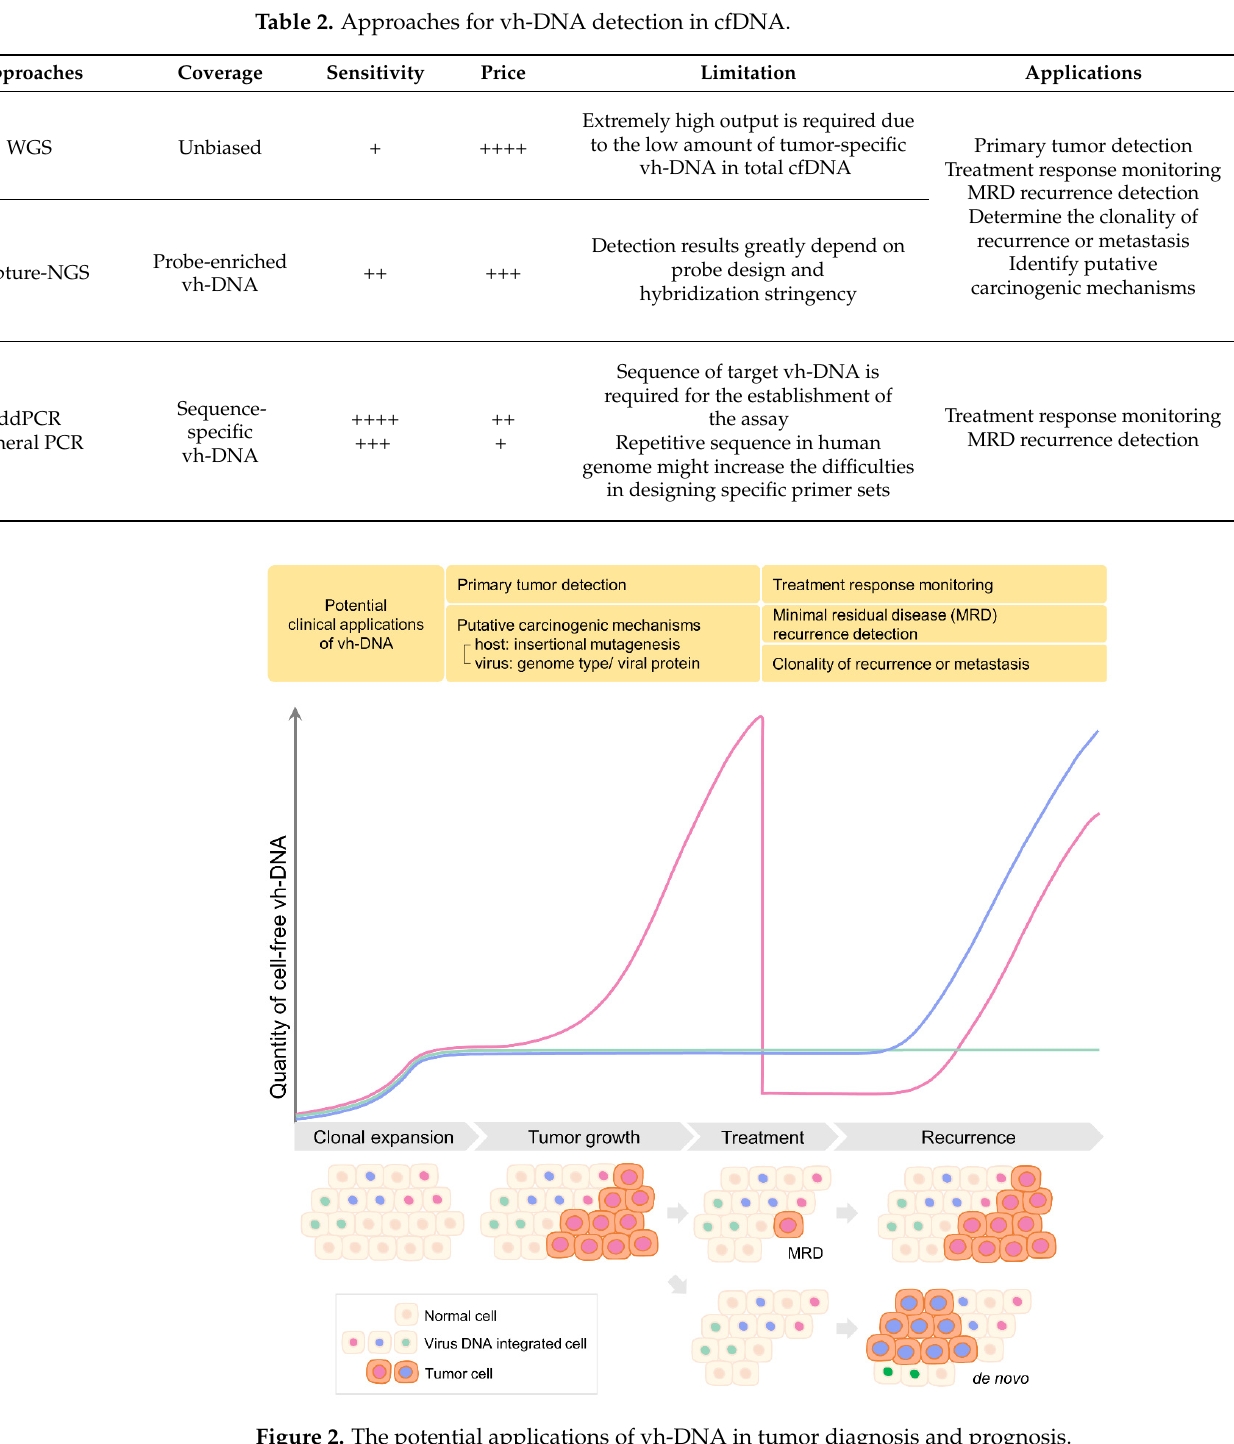
Figure 2. The potential applications of vh-DNA in tumor diagnosis and prognosis.